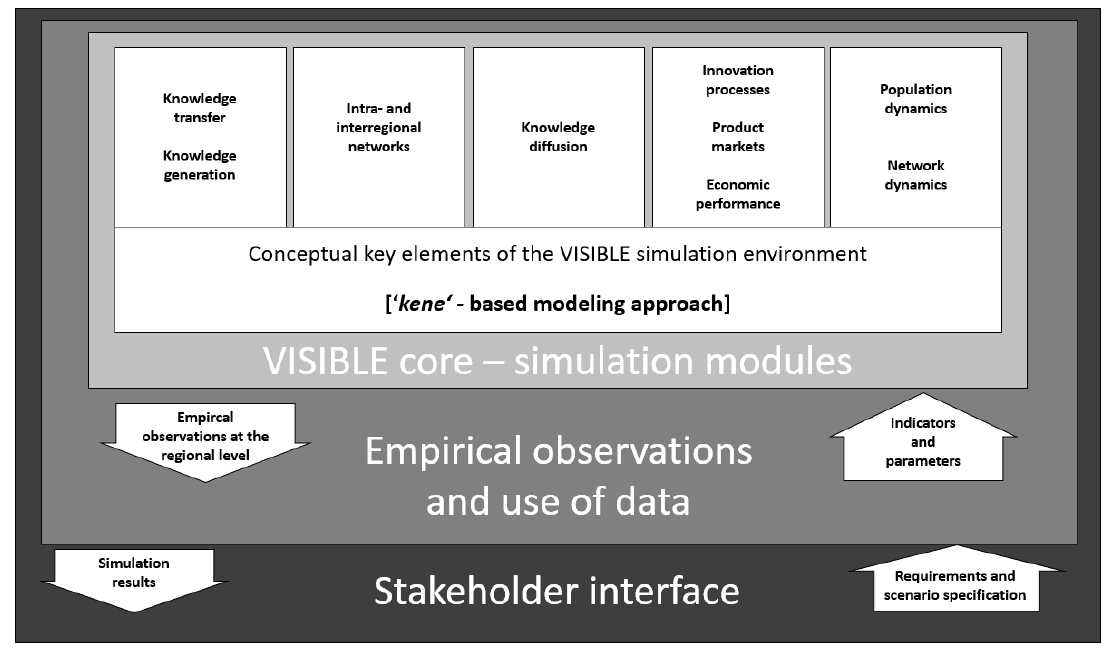
Figure 1. Schematic illustration of the Virtual Simulation Lab for the Analysis of Investments in Learning and Education (VISIBLE) simulation environment.